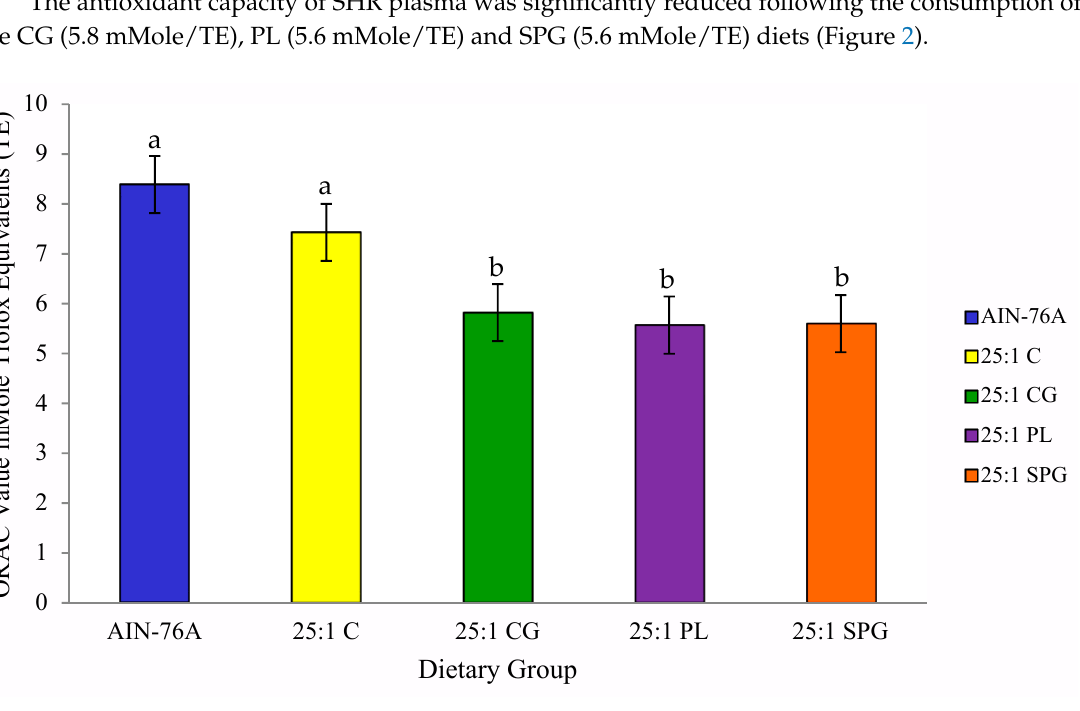
Table 5. Plasma lipid profile of SHRs consuming the AIN-76A diet and diets with a 25:1 ω -6/ ω -3 FAR for 6 weeks.